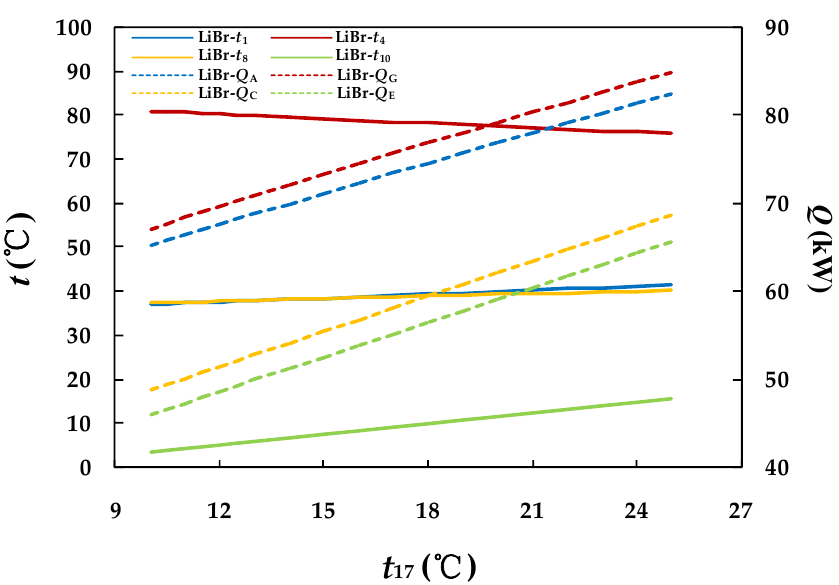
Figure 19. Variation of COP and exergy efficiency with the chilled water inlet temperature for the two absorption chillers.